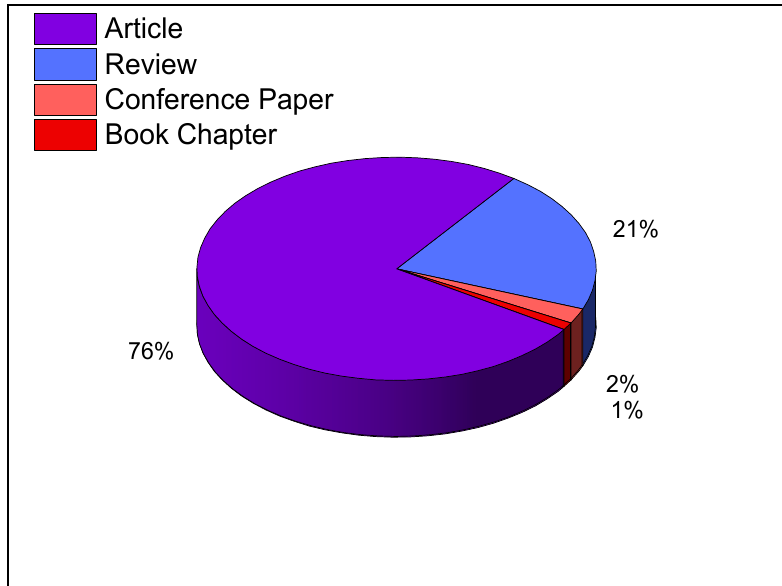
Figure 6. Distribution of documents by type (based on data from Scopus).